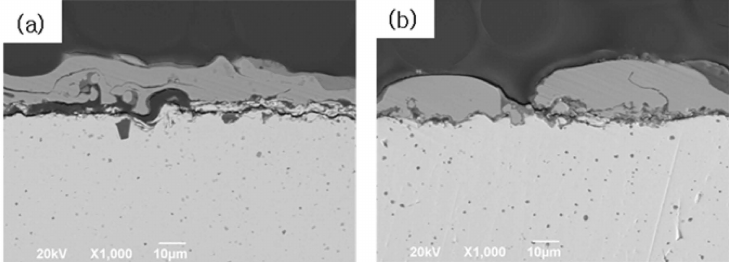
Figure 1. Cross-sectional microstructures of FeCrAl plasma thermal spray-coated TZM alloy: